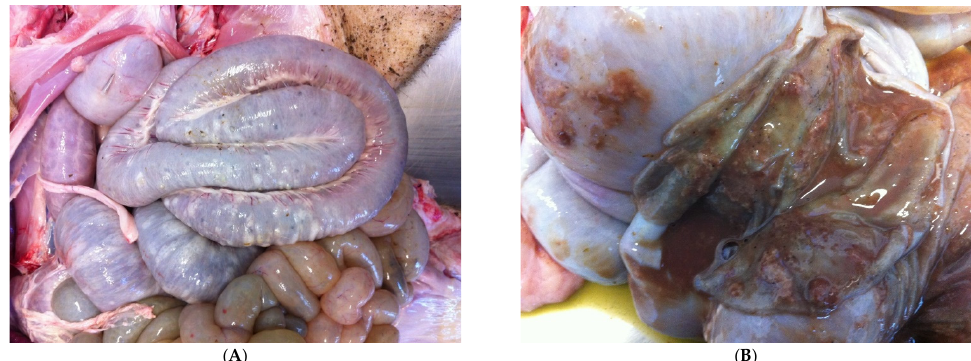
Figure 27. Colon of pig affected by SD shows oedema of the intestinal wall ( A ) and intestinal mucosa showing mucous, fibrin and blood ( B ). Thick pseudomembranes consisting of fibrin, mucous and blood are observed as the disease progresses, while a thin layer of fibrino ‐ necrotic exudate characterises lesions de ‐ scribed in chronic cases [91].